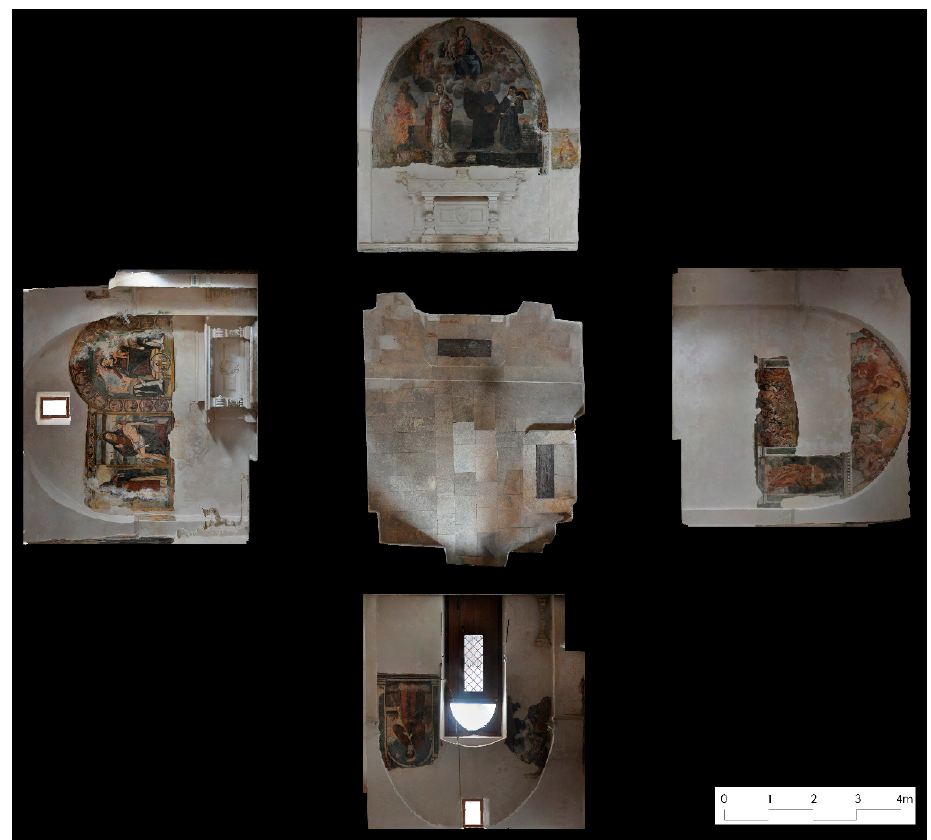
Figure 6. Orthogonal projection of the inside of the structure: orthophotos (in very high resolution) of the single façade and floor of the church.